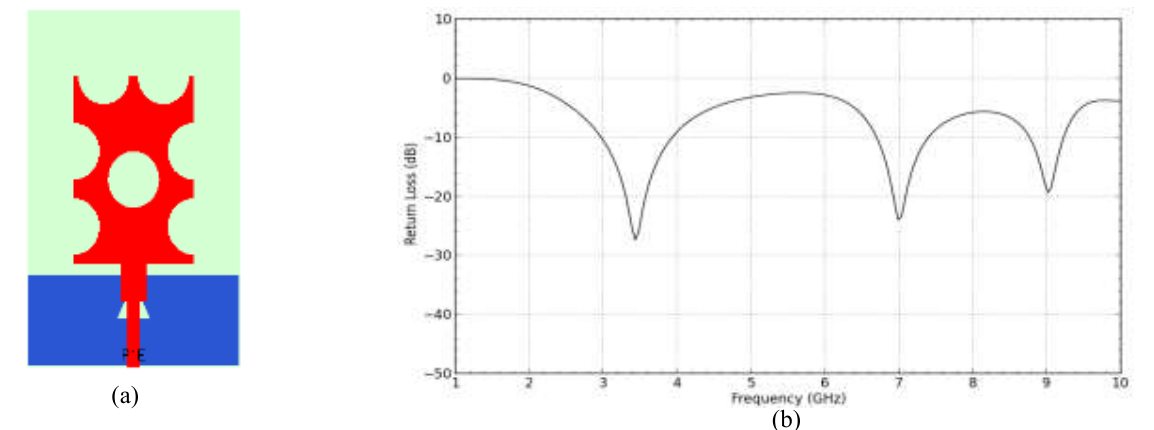
Figure 4: (a) Antenna with one triangle shaped defect and (b) its return loss (simulated)